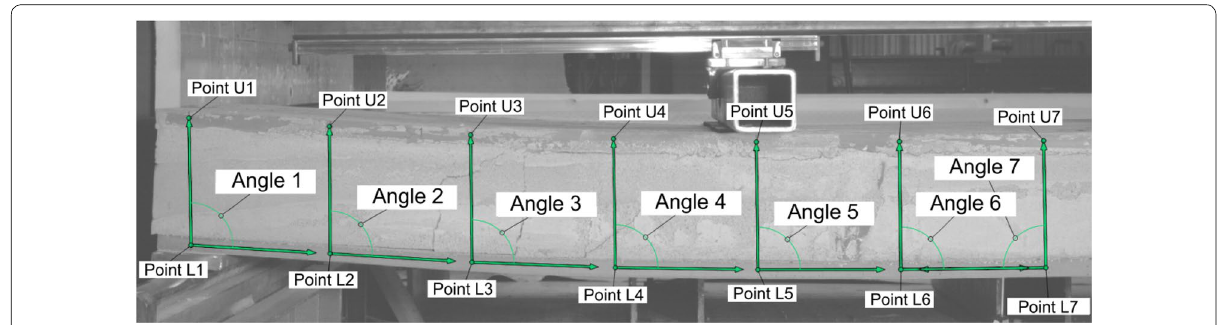
Fig. 11 Image from the optical system of the left side of the beam